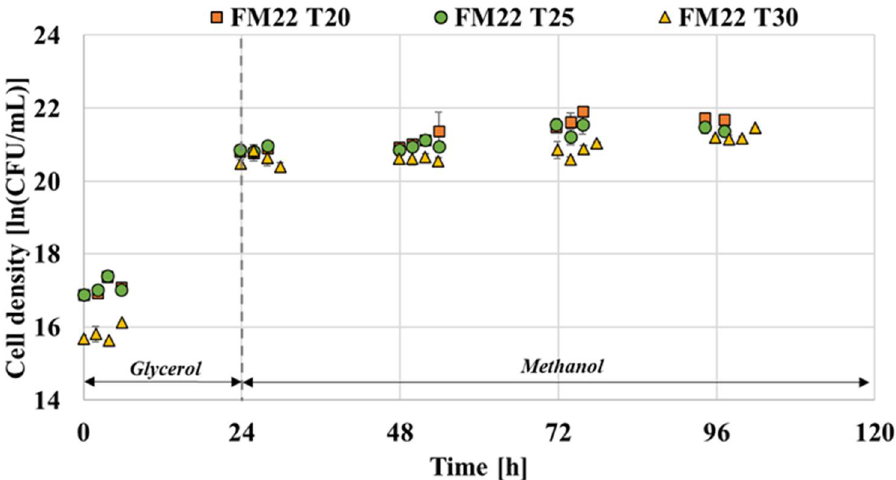
Figure 4. Effect of temperature on the growth of P. pastoris grown on FM22 and BMGY media with an induction pH of 6.0.